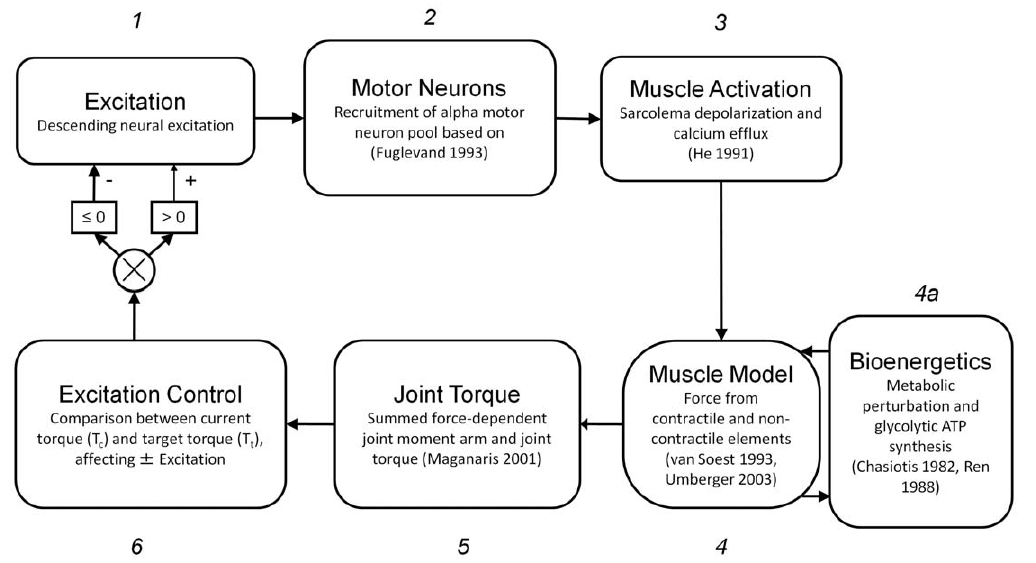
Figure 2. Computational Approach. The model runs using a forward-integration routine to calculate each model step (1–6) at each time point for the duration of the simulation. Primary literature sources pertinent to model functions are listed with each step.